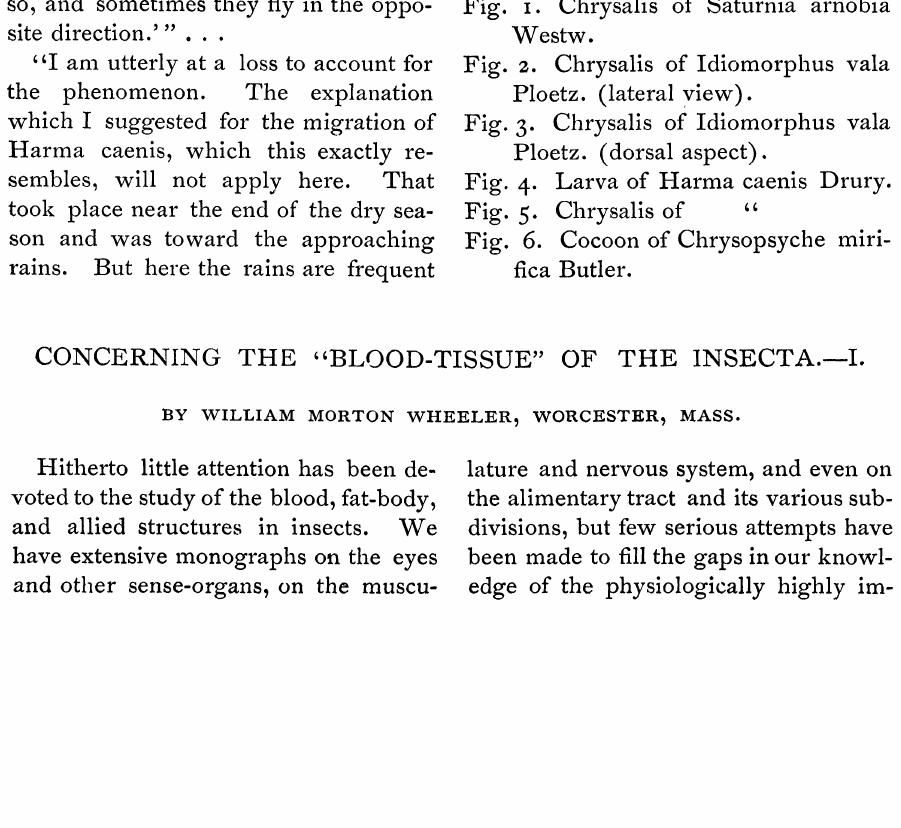
Fig. I. Chrysalis of Saturnia arnobia Westw. Fig. 2. Chrysalis of Idiomorphus vala Ploetz. (lateral ,view). Fig. 3" Chrysalis of Idiomorphus vala Ploetz. (dorsal aspect). Fig. 4. Larva of Harma caenis Drury. Fig. 5" Chrysalis of " Fig. 6. Cocoon of Chrysopsyche miri- flca